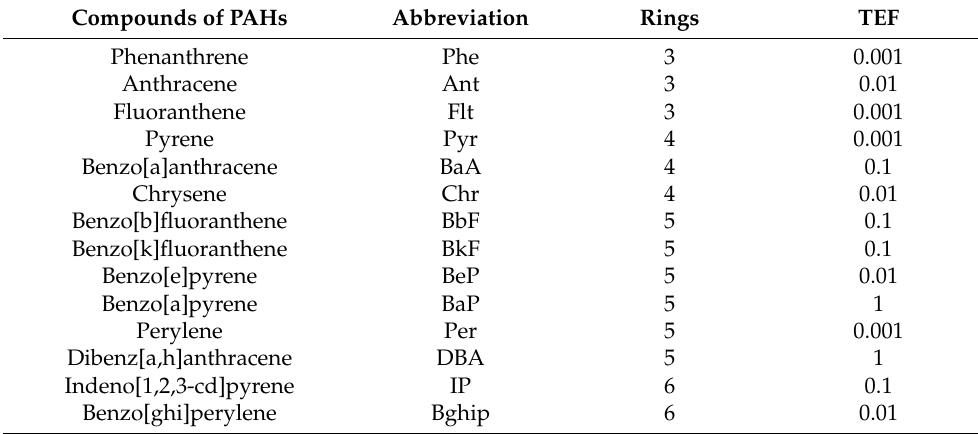
Table 1. The toxic equivalent factors of polycyclic aromatic hydrocarbons (PAHs)